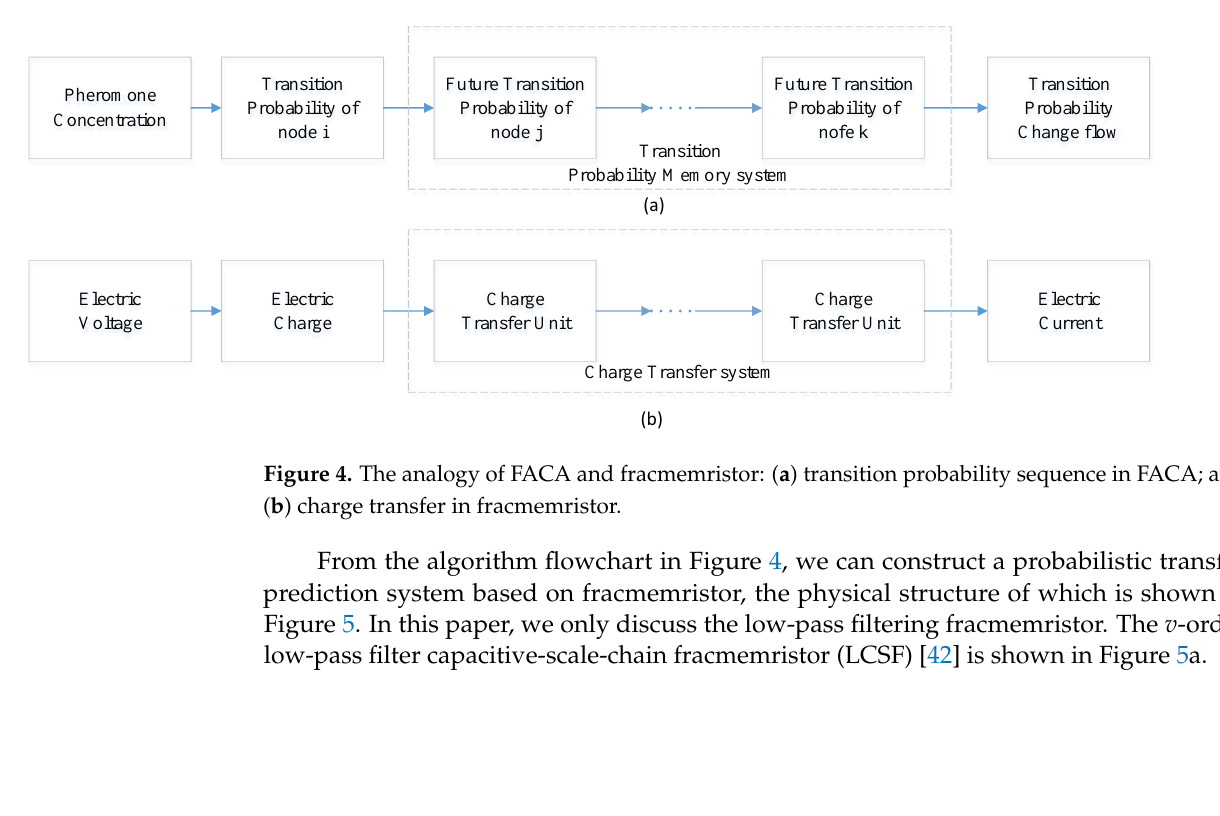
(b) Figure 5. ( a ) Low-pass capacitive fracmemristor; and ( b ) high-pass capacitive fracmemristor. We perform a mathematical analysis of the LCSF. The nth series circuit of v